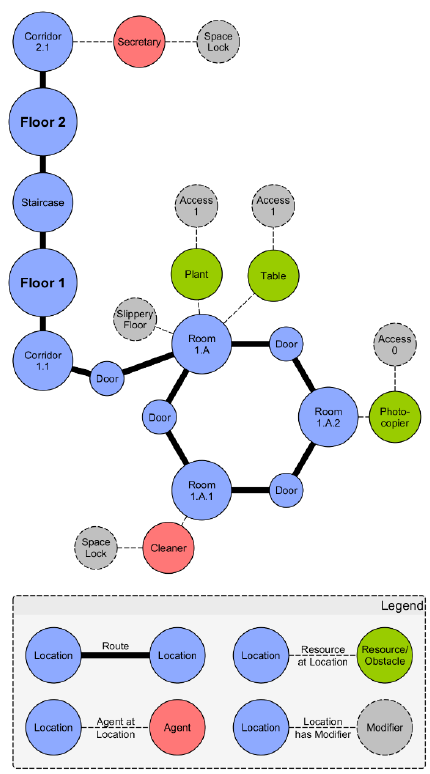
Figure 11 Application of the navigation framework. Blue circle represent entities (in this case sub-spaces) whose dominant trait is Location. Red circles represent entities (in this case agents) whose dominant trait is Position. Green circles represent entities whose dominant trait is